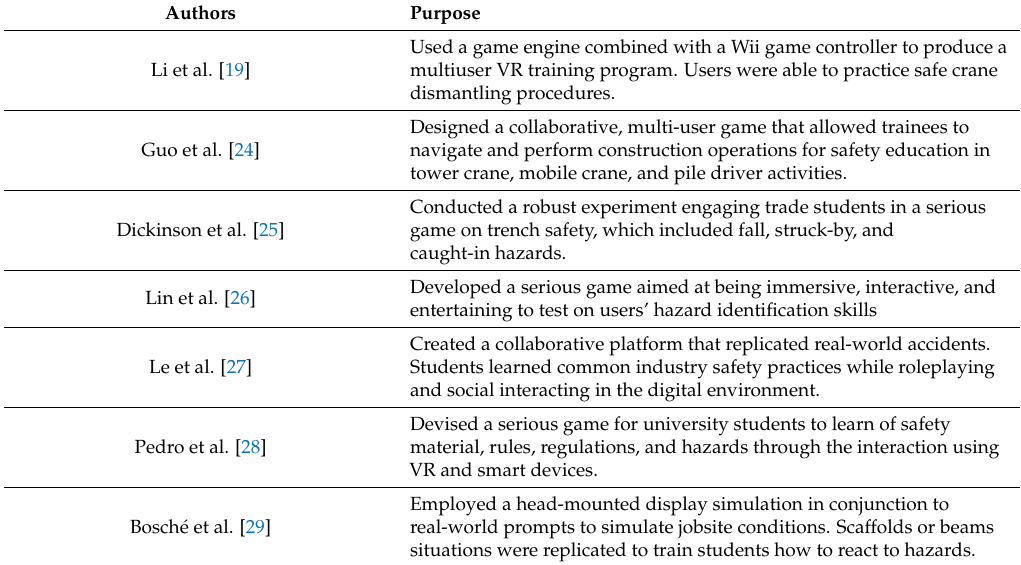
Table 1. VR Applications for Safety